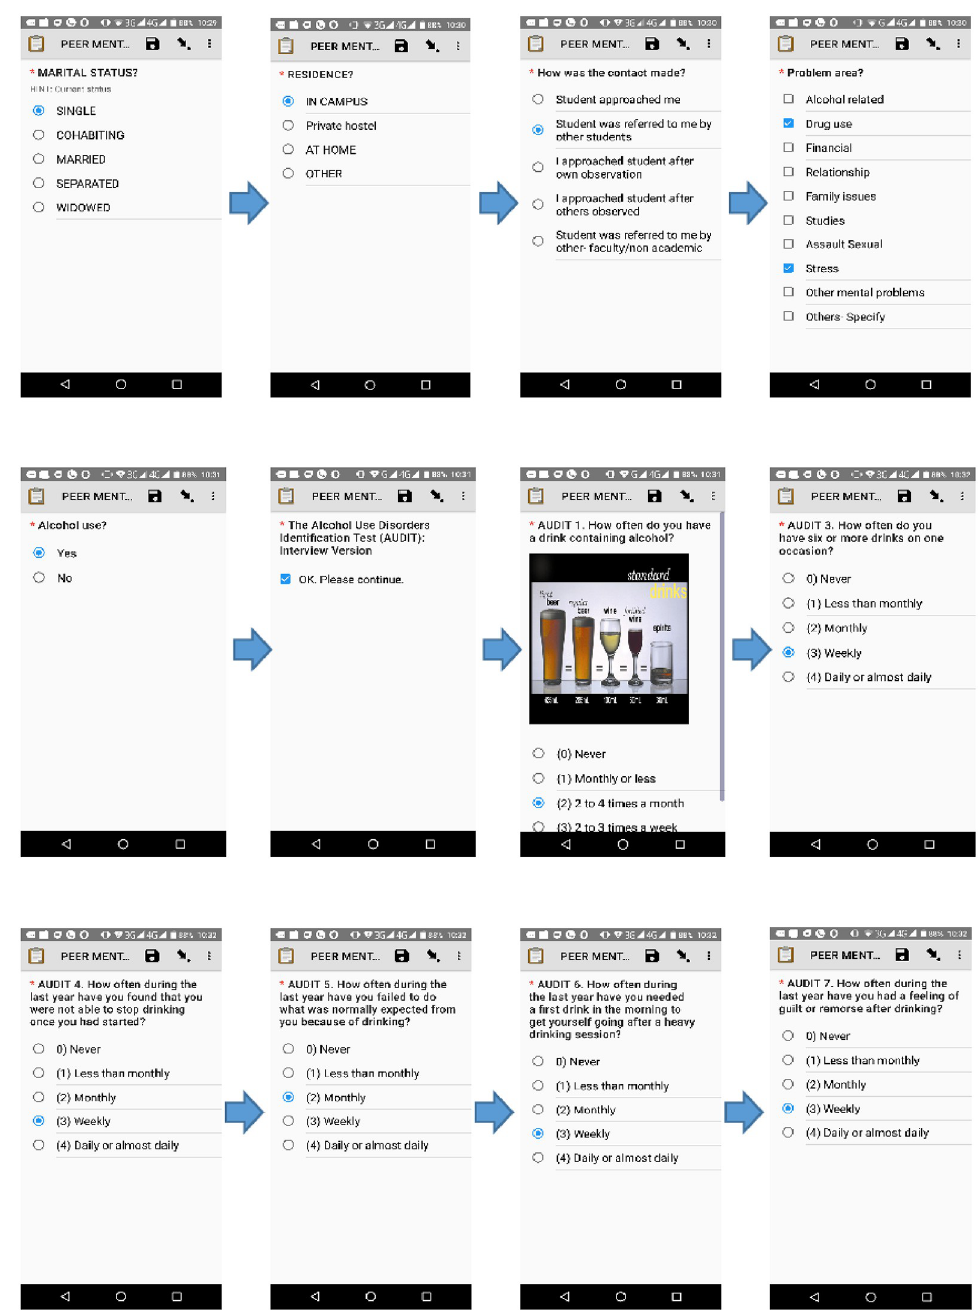
Fig 1. Screen-by-screen access to the mHealth-based